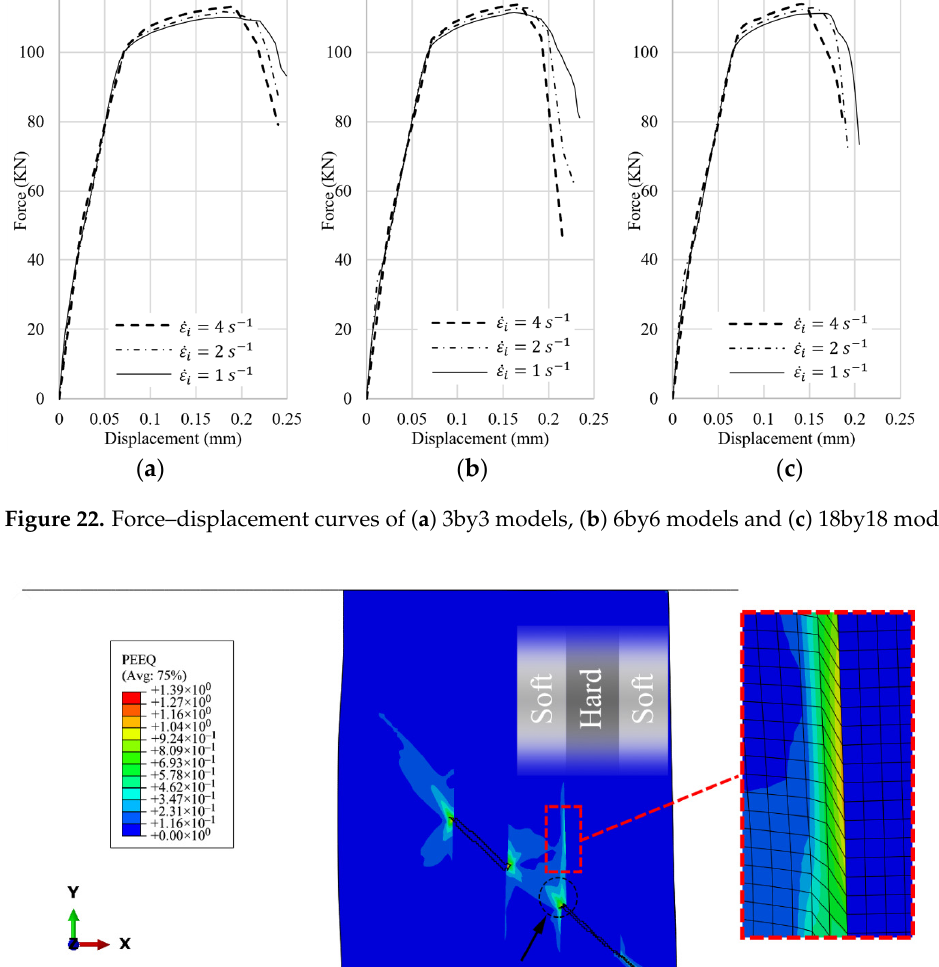
Figure 22. Force–displacement curves of ( a ) 3by3 models, ( b ) 6by6 models and ( c ) 18by18 models.